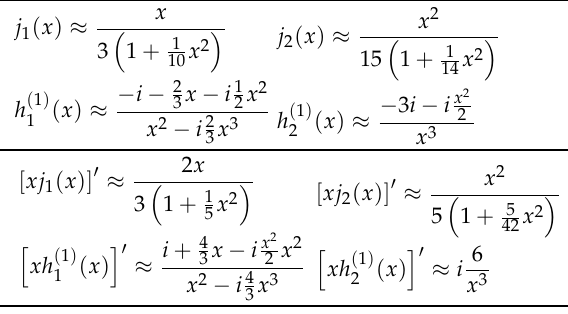
( 1 ) ( x ) and their derivatives. n